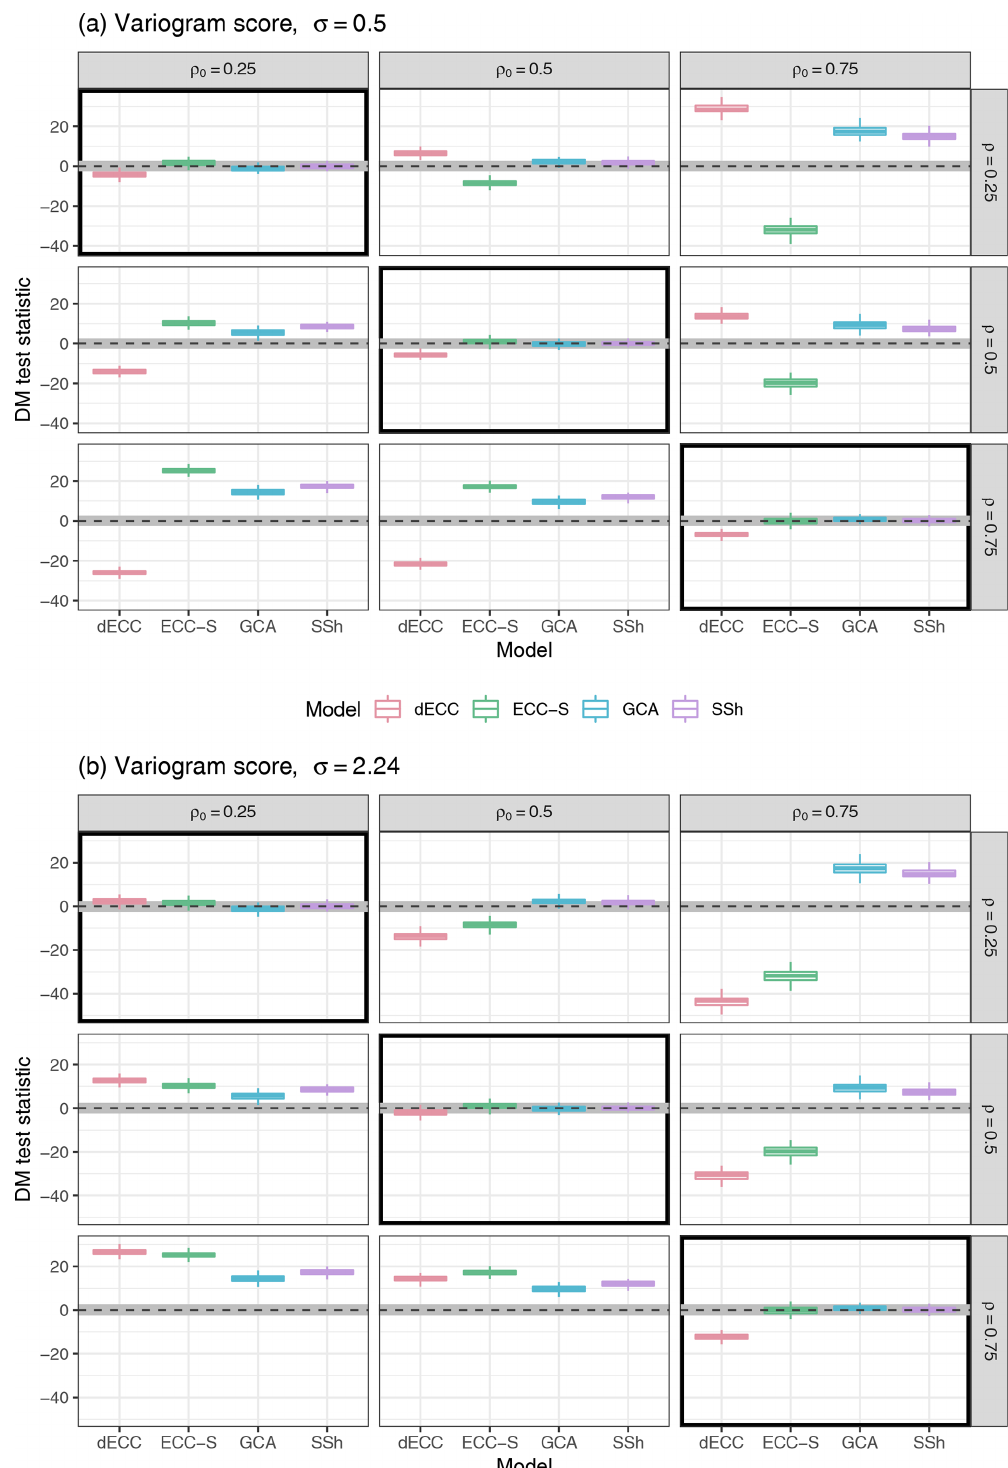
Figure 3. As Fig. 2 but summarizing results in terms of the